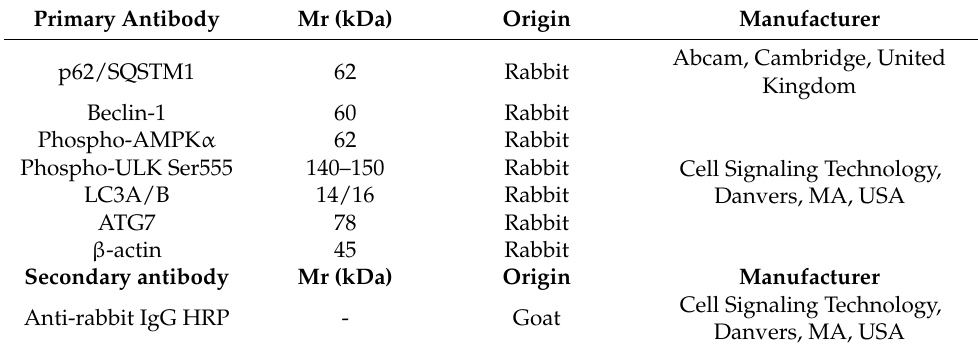
Table 3. List of Western blot